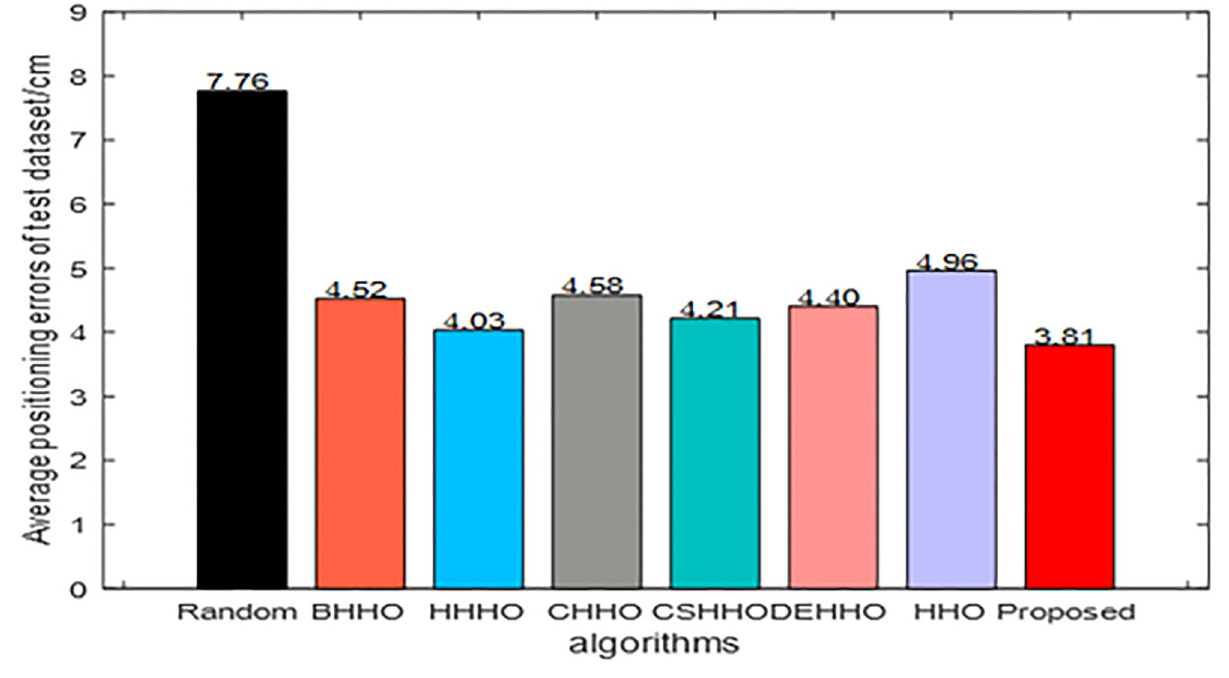
Fig 11. Average positioning errors of the test dataset.